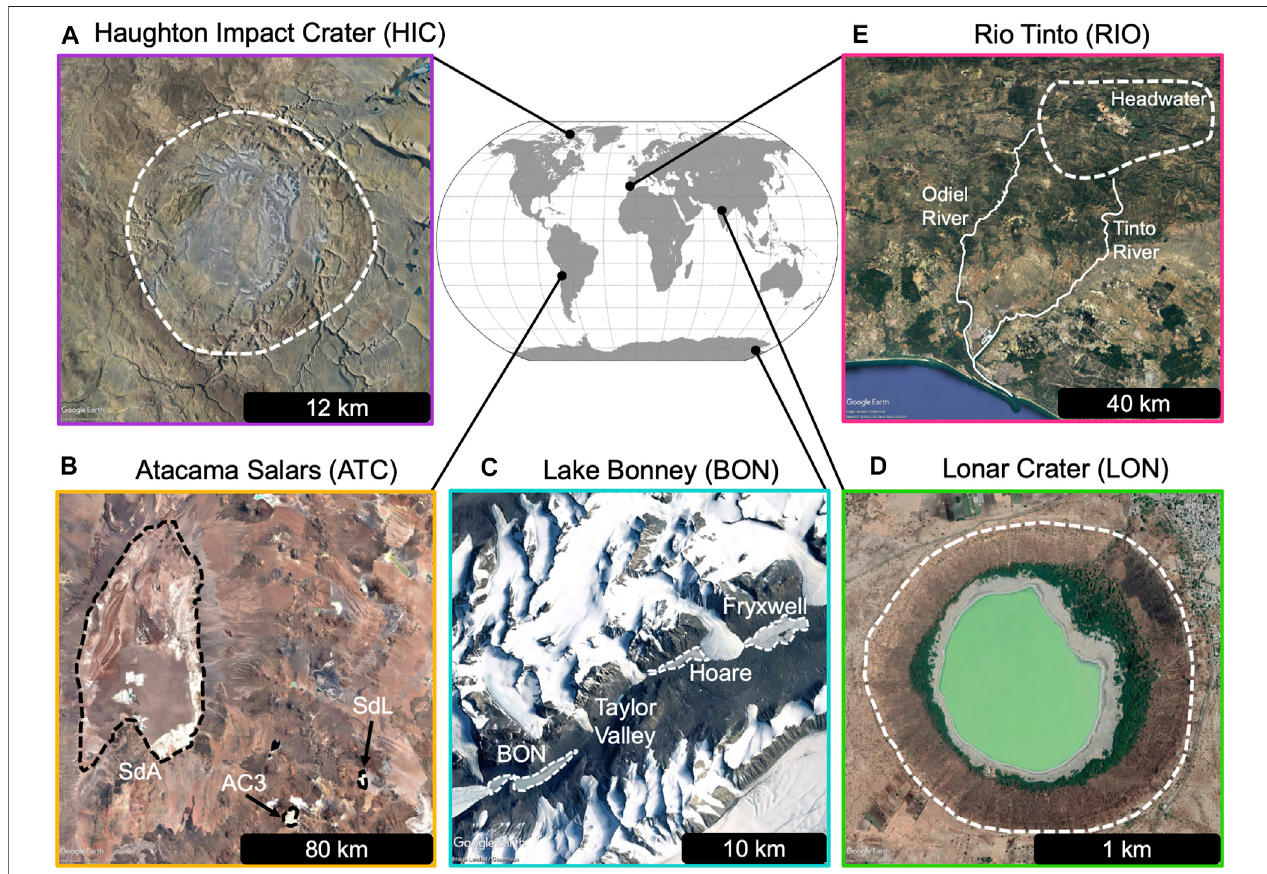
FIGURE 3 | Map of the Earth showing the locations of fi ve terrestrial Mars analogs. Panels show the regional context of each site. (A) Haughton Impact Crater on Devon Island, Nunavut Canada. Seasonal meltwater fl ows out of the crater through the river valley on the northeast side of the crater wall. (B) The Atacama Desert in Chile,thisregioncontainsmany hypersalinesalt fl atsincludingSalar deAtacama(SdA),SalardeLaco(SdL),Salar deAguasCalientes3(AC3). (C) LakeBonneyisoneof several perennially ice-covered, chemically strati fi ed lakes surrounded by bare rock in the Mcmurdo Dry Valleys of Antarctica. Neighbording lakes include Fryxell and Hoare. Glacial streams and the lake margins (moat) melt during the brief Austral summer. (D) Lonar Crater and lake in Lonar, India. Lonar is the only basaltic crater lake on Earth. The lake ’ s watershed experiences heavy agricultural cultivation. (E) The Rio Tinto River fl ows from heavily mined headwaters to the Atlantic Ocean. The headwaters are highly acidic and are characterized by high concentrations of iron and other heavy